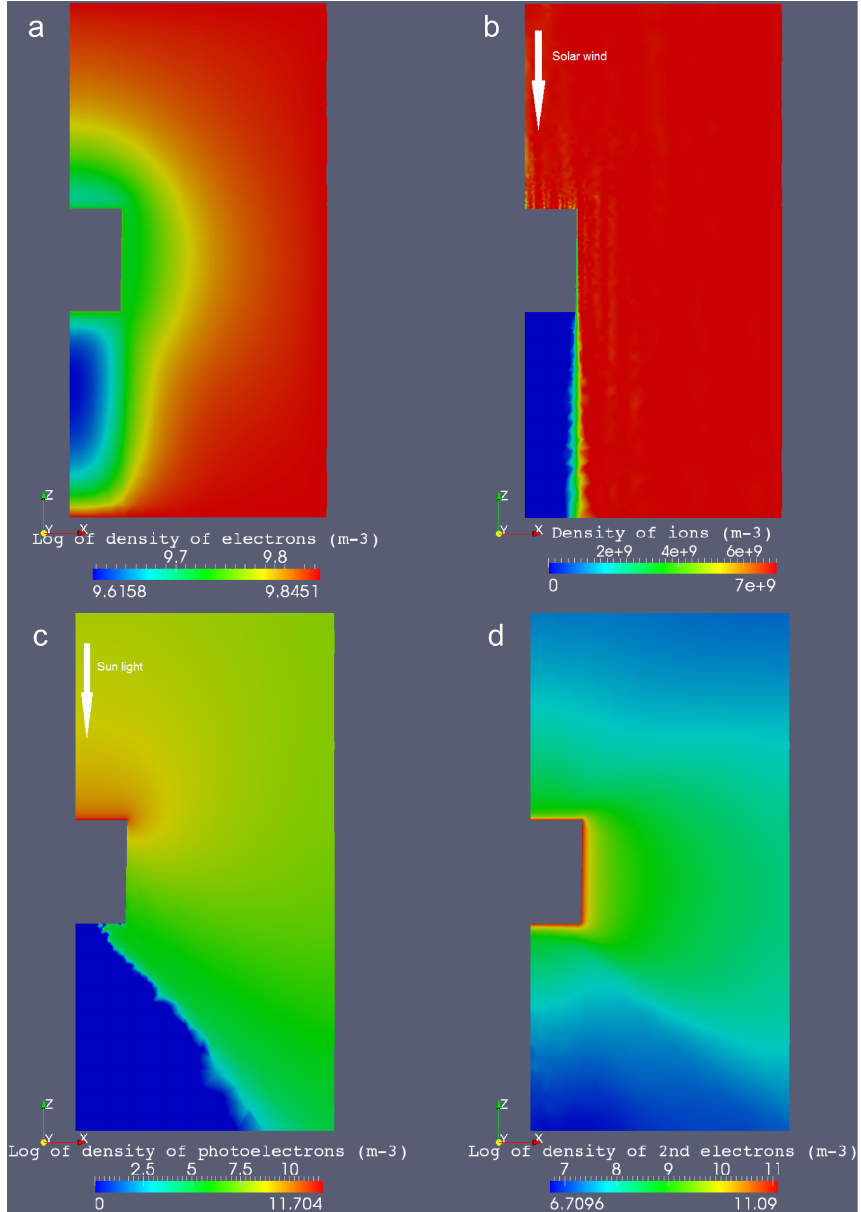
Fig. 8. Cross comparison simulation B (SPIS): population density maps ( T ph = 3eV): (a–d) from the upper left figure to the lower right figure. (a) Thermal electrons, (b) Ions, (c) Photoelectrons, (d) Secondary